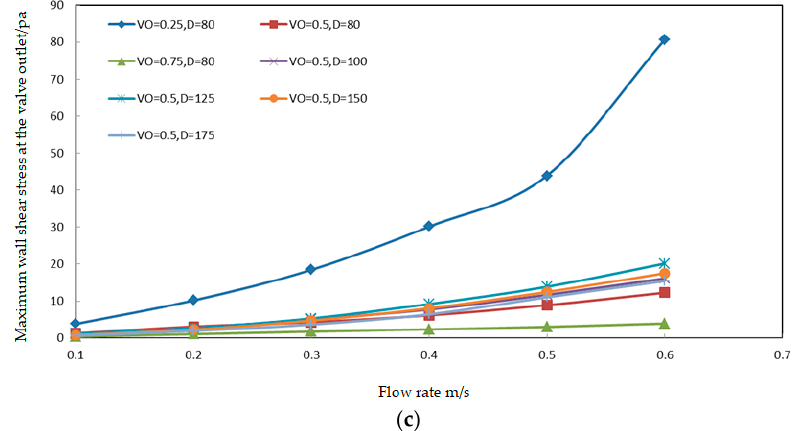
Figure 22. The influence of flow rate on the erosion of the valve; ( a ) Trend of maximum wall pressure; ( b ) Trend of maximum wall shear stress at the valve inlet; ( c ) Trend of maximum wall shear stress at the valve outlet.